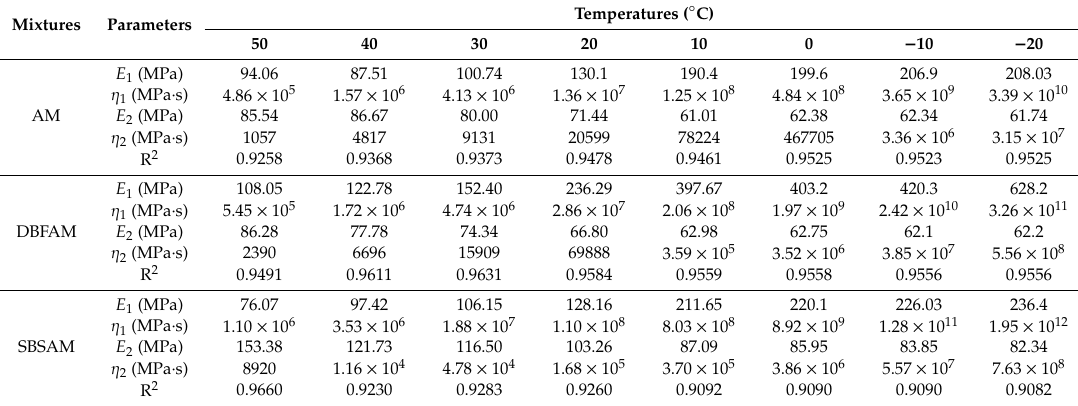
Table 7. The fitting parameters of the creep compliance based on the Burgers